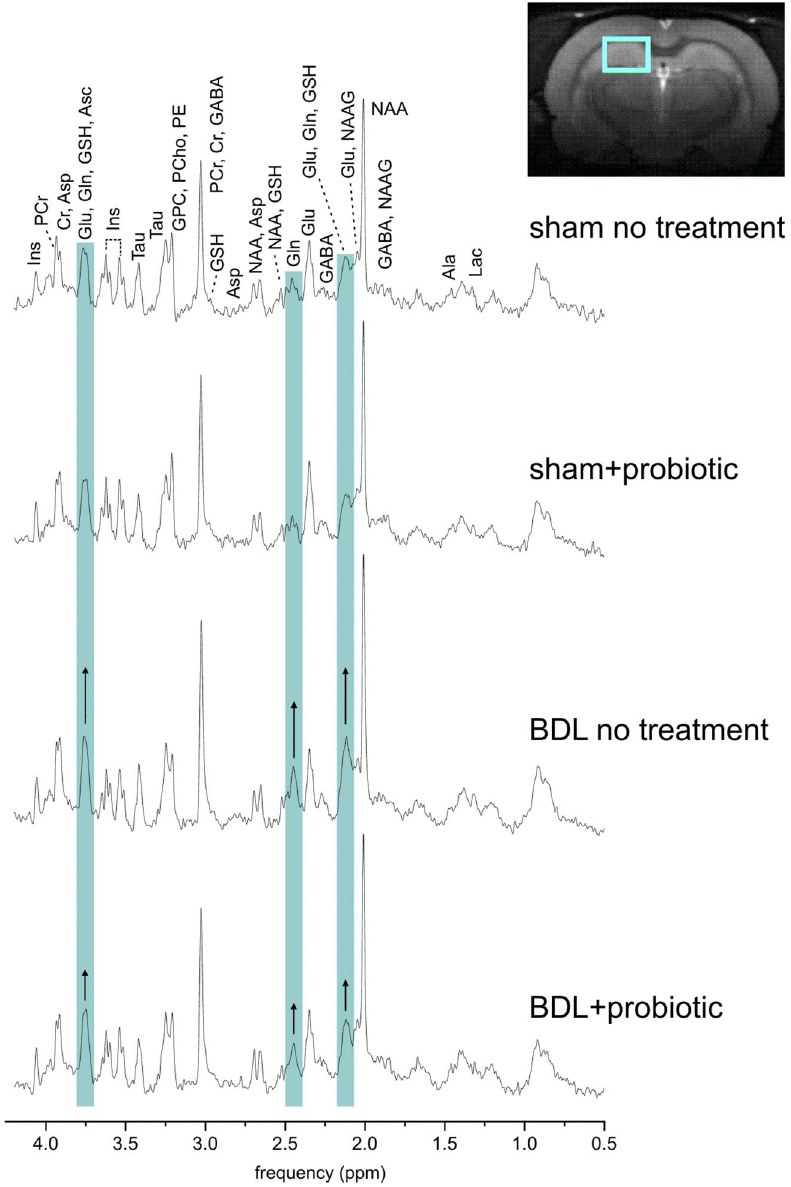
Figure 2. Representative in vivo 1 H MRS spectra 8 weeks after surgery from sham rat, sham + probiotic rat, BDL rat and BDL + probiotic rat (SPECIAL sequence, TE = 2.8 ms, TR = 4000 ms, 160 averages). Blue bands highlight glutamine resonance that is visibly increased in BDL rats with smaller increase in BDL + probiotic rat. T 2 weighted axial image of the rat brain indicates position of measured volume (2 × 2.8 × 2mm 3 ) placed in dorsal hippocampus. Ala alanine, Asc ascorbate, Asp aspartate, GPC glycerophosphocholine, PCho phosphocholine, Cr creatine, PCr phosphocreatine, GABA γ-aminobutyric acid, Glc glucose, Gln glutamine, Glu glutamate, GSH glutathione, mIns myo-inositol, Lac lactate, NAA N -acetylaspartate, NAAG N -acetylaspartylglutamate, PE phosphoethanolamine, Tau